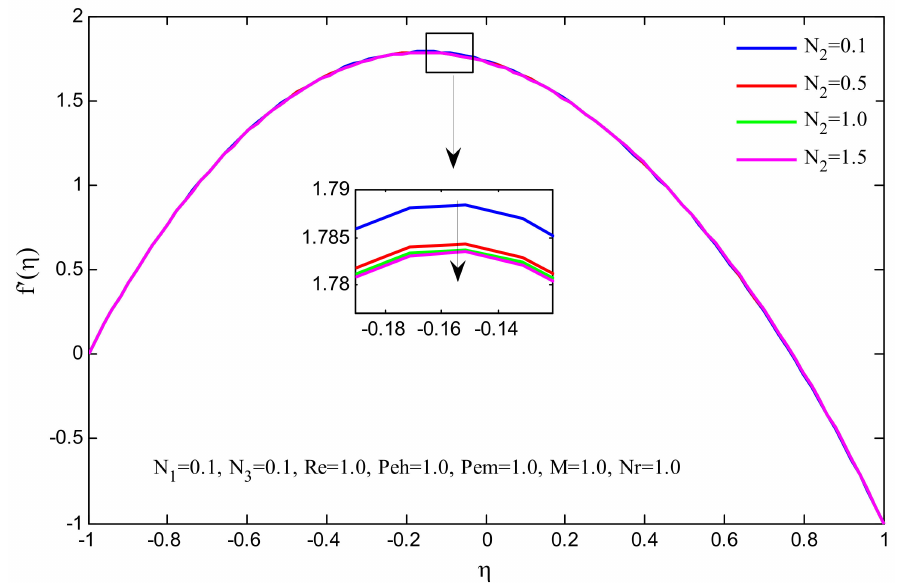
Figure 3. Effect of N 2 on simulated